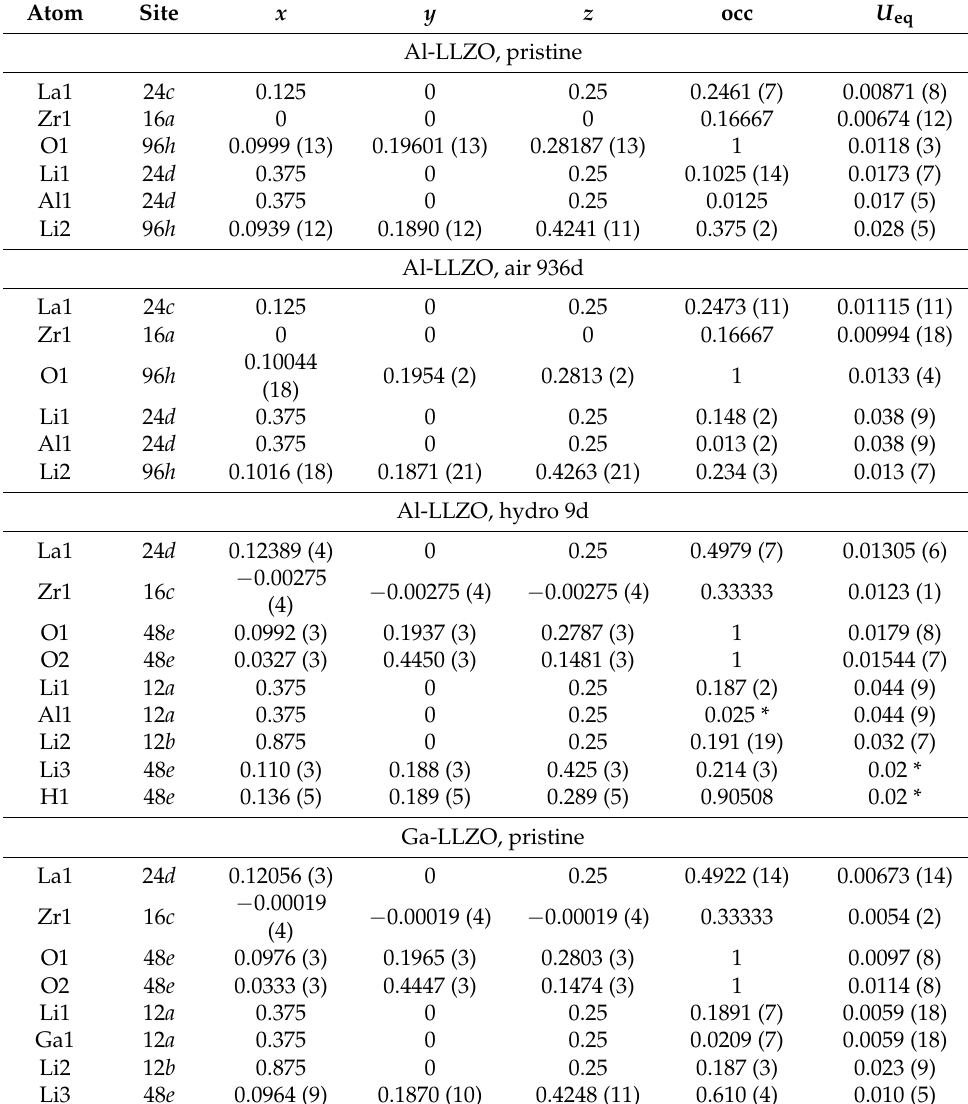
Table 3. Fractional atomic coordinates, site occupation factors (sof), and equivalent isotropic atomic displacement parameters U eq for the Al- and Ga-stabilized LLZO samples are listed in Table